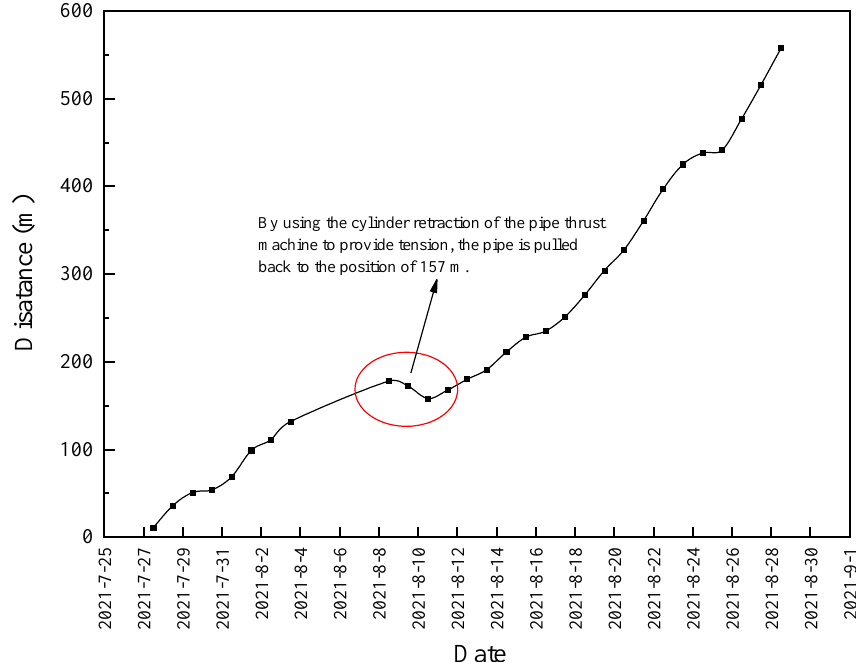
Figure 8. The thrust distance over time.